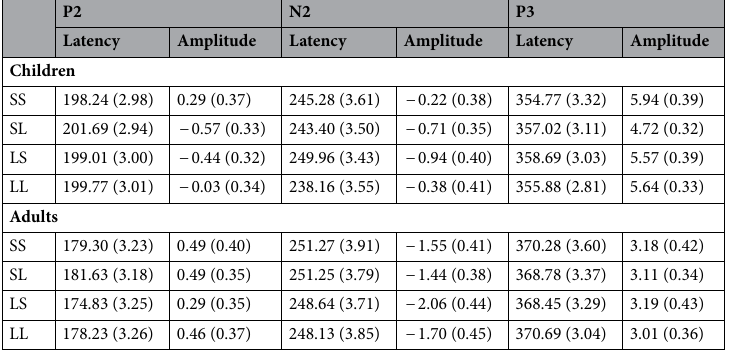
Table 5. Means and standard errors of ERP latencies and amplitudes in children and adults. SS Small amount and short delay condition, SL small amount and long delay condition, LS large amount and short delay condition, LL large amount and long delay condition.